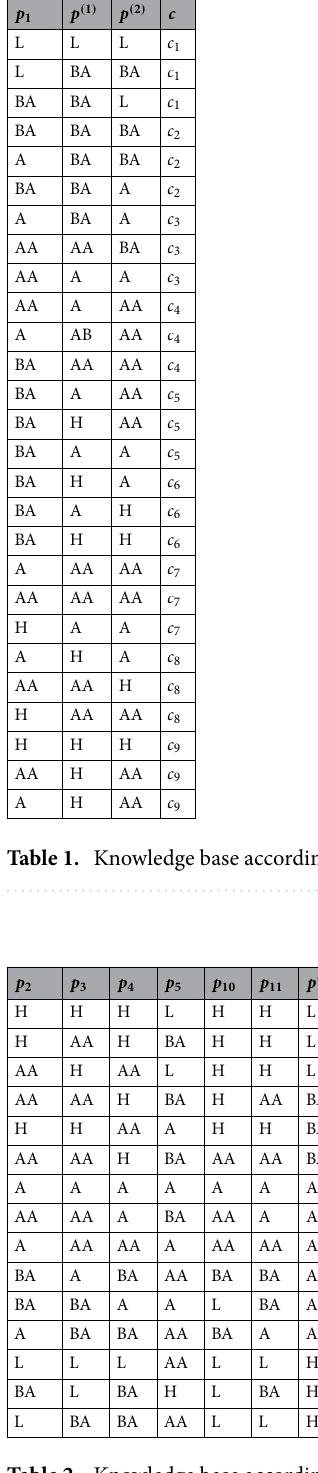
Table 2. Knowledge base according to equation p ( 1 ) = f p ( 1